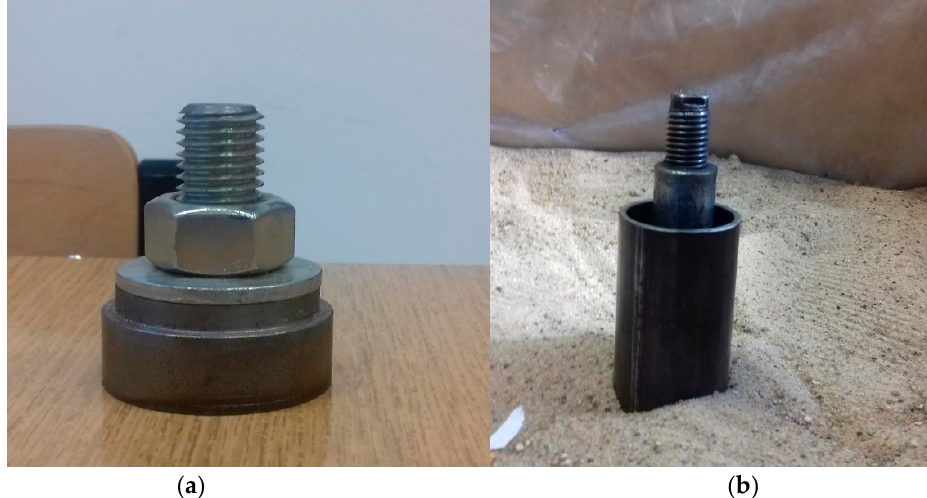
Figure 4. ( a ) Steel bottom of model pile base. ( b ) Pole placed inside the pipe.